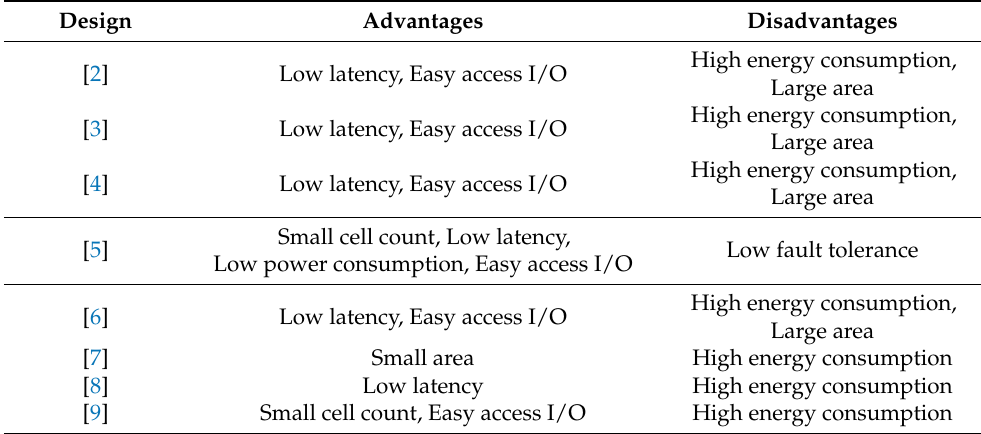
Table 1. Advantages and disadvantages of alternative XOR/XNOR